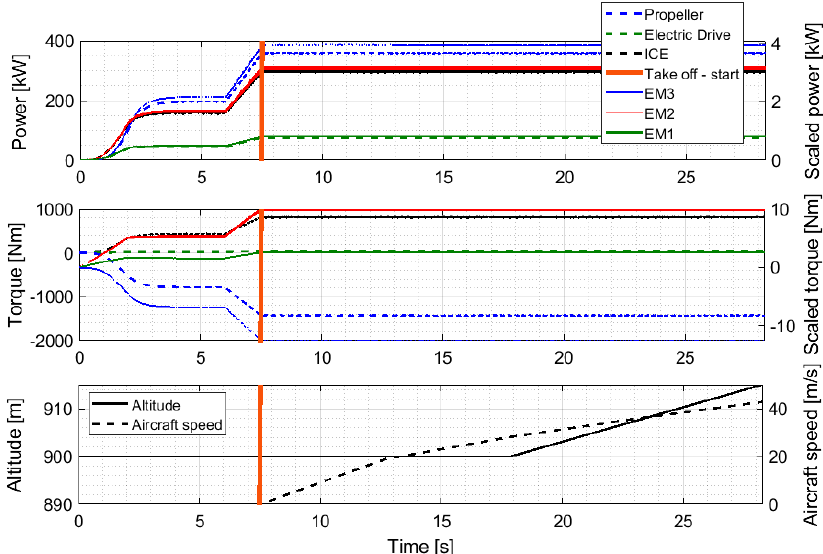
Figure 12. Comparison between simulated behavior of the real propulsion system and the scaled virtual test bench.